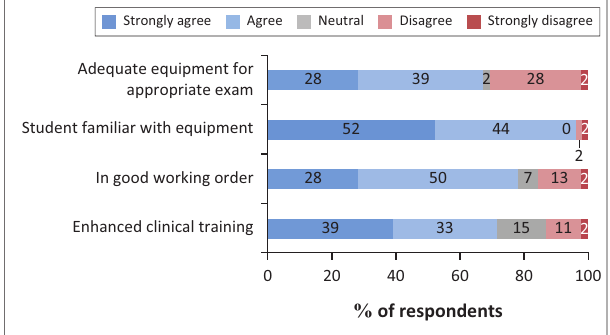
Adequate equipment for appropriate exam